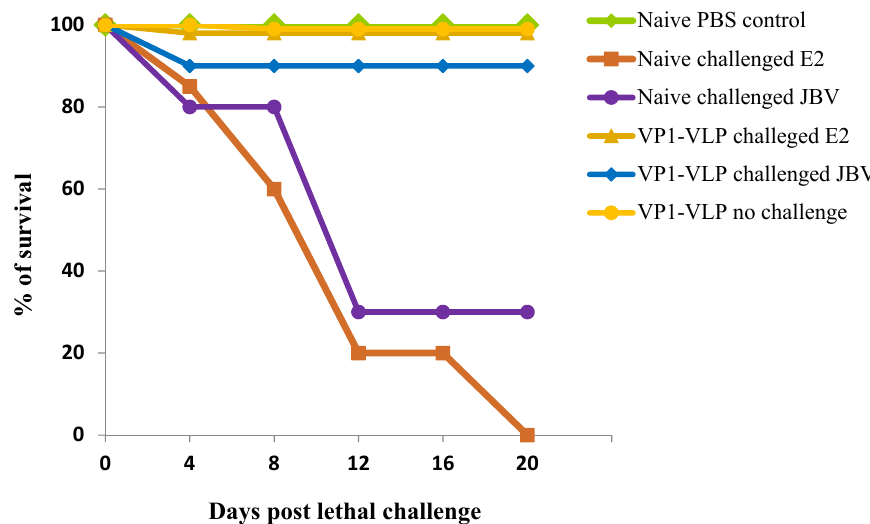
Figure 7. Body weight changes observed in all mice groups at di ff erent days post lethal challenge with pathogenic E2 and JBV strains. Mice groups not immunized and challenged by pathogenic strains showed substantial decrease in body weight percentage. PBS naïve mice group represents the control group.